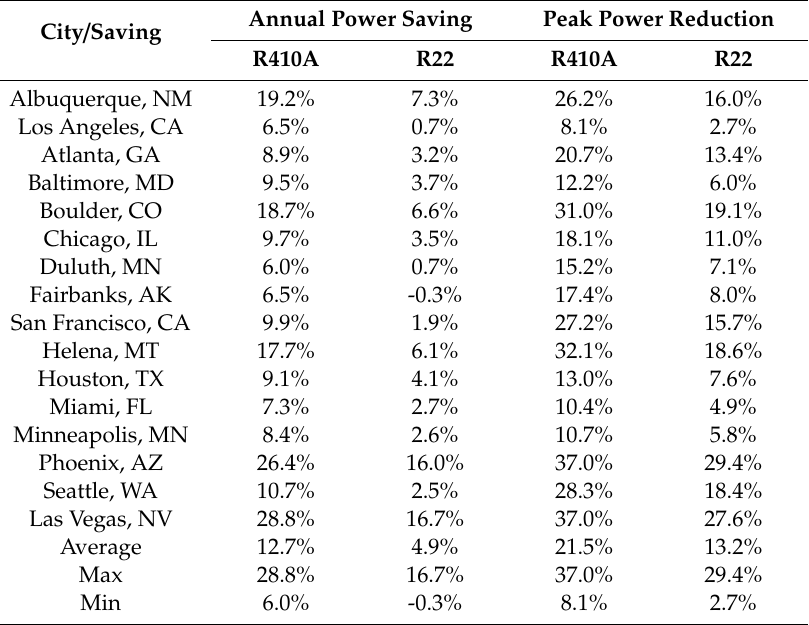
Table 4. Supermarket: Annual energy savings and peak power